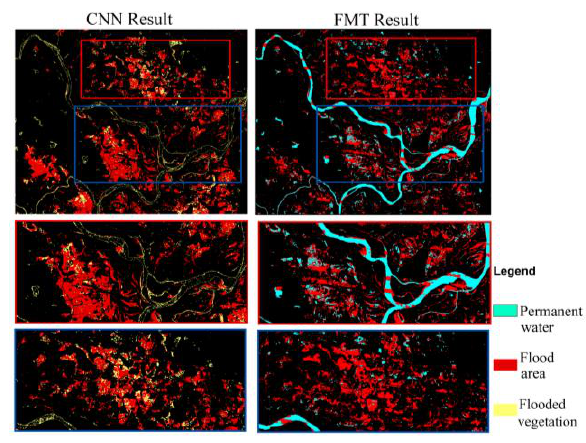
Figure 9 . The CNN and the FMT results from the Ca River, Vietnam